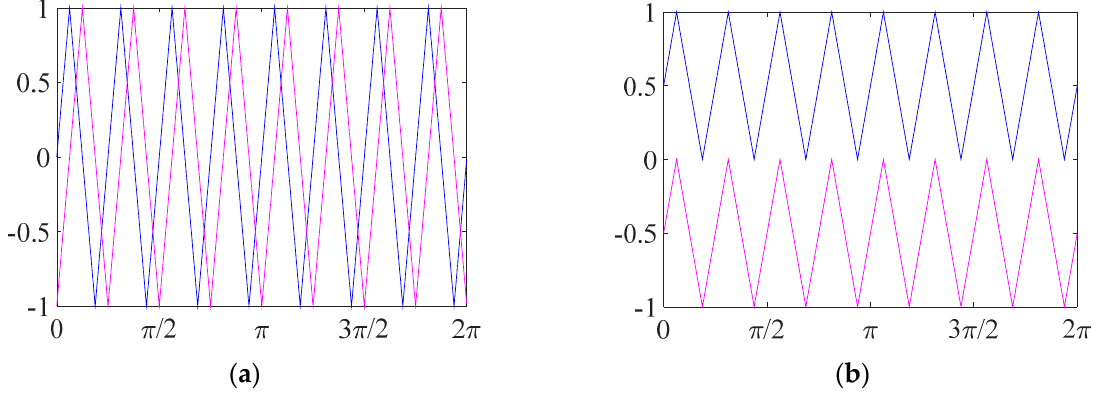
Figure 3. Carrier pattern: ( a ) Phase Shifted—PS; ( b ) Suppressed Carrier Arrangement Modula ‐